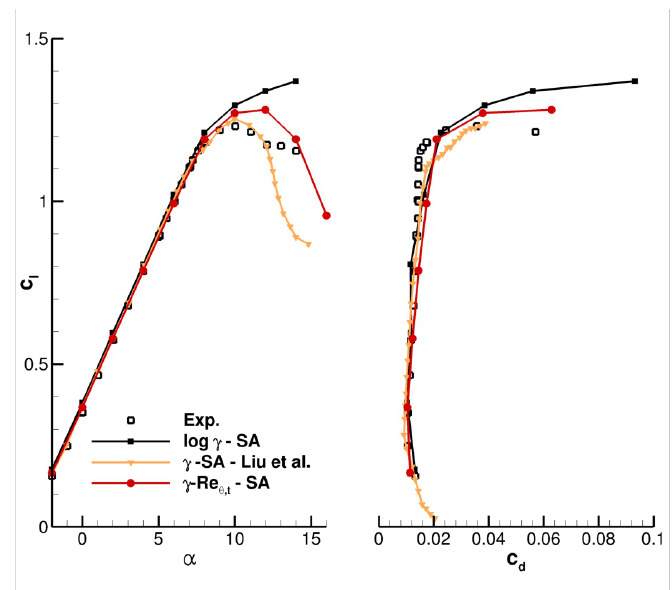
Figure 13. E387, Re = 2 × 10 5 . Force